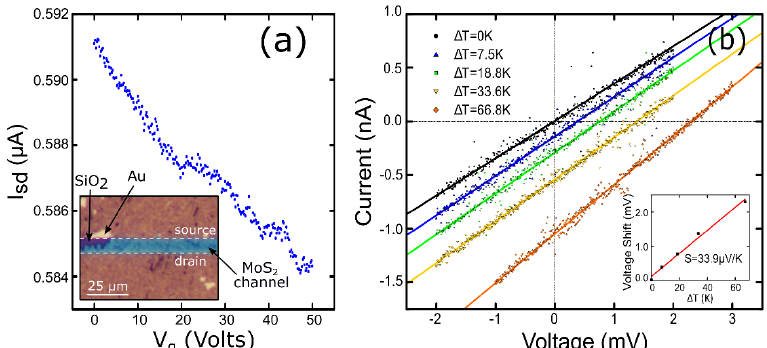
Figure 5. ( a ) Source-drain current vs. gate voltage measured in dark conditions and at V sd = 1 V. The inset shows an optical image of the device measured (channel length = 10 µm, channel width = 1 mm). ( b ) Seebeck effect measurement on an MoS 2 layer on a mica substrate by applying a temperature difference between electrodes. The inset shows the linear relationship between the thermovoltage slope.